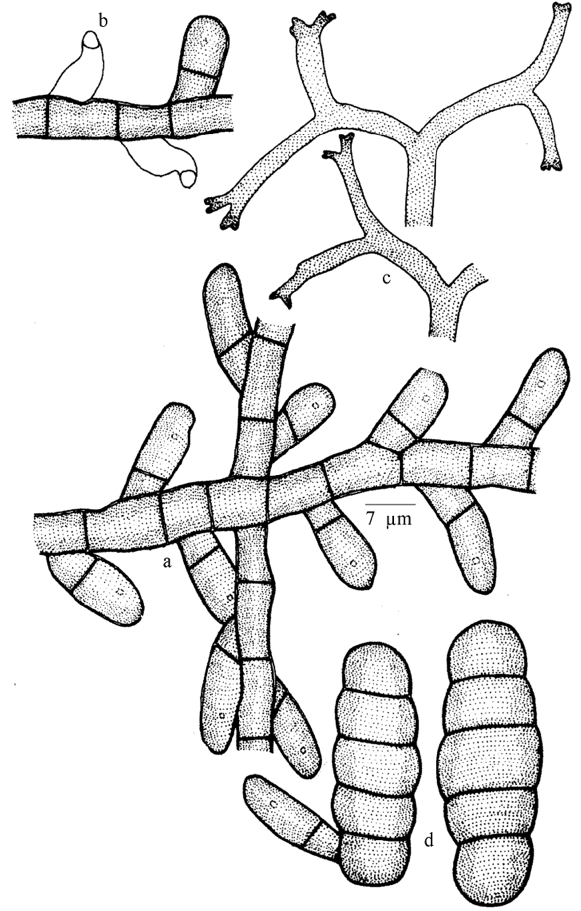
Figure 122. Meliola tenella a - Appressorium; b - Phialide; c - Apical portion of mycelial setae; d -